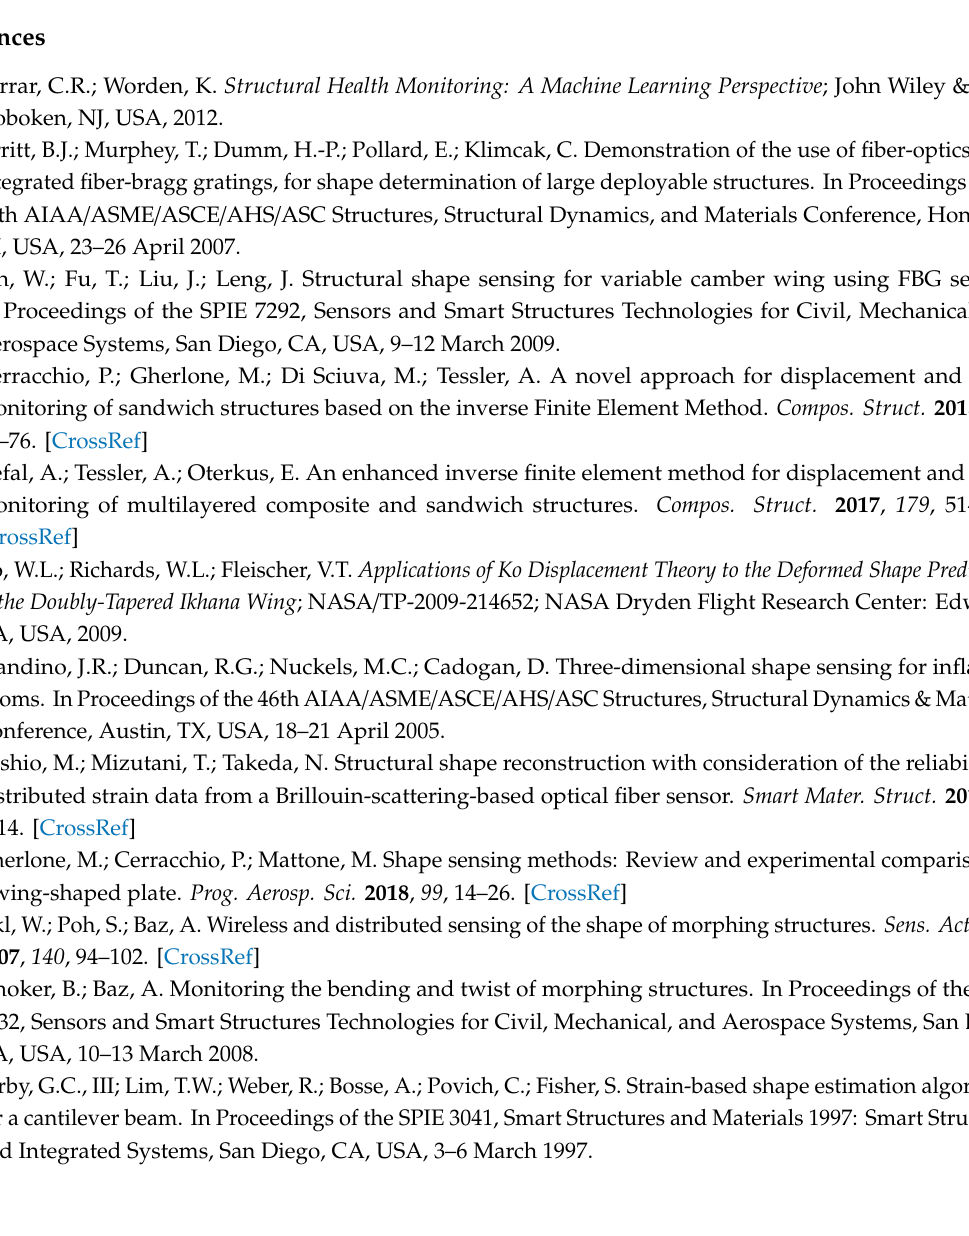
Figure A1. Orientation of the element local coordinate system ( x e , y e ) , with respect to the global coordinate system ( x g , y g ) , of the